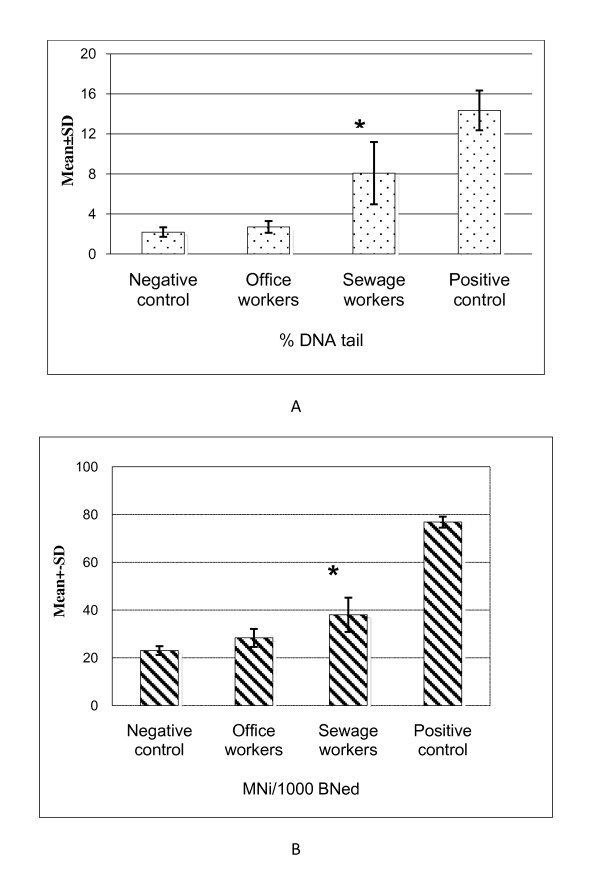
Effects of 24 h exposure to urine organic extract evaluated by comet and micronucleus assay performed on HepG2 cells. A) The bars are related to the means ± SD values of percent DNA tail obtained by comet assay. B) The bars are related to means ± SD values of MNi/1000 BNed obtained by Micronucleus assay. For comet assay, nine experiments were performed. For micronucleus assay, five experiments were performed. For both assays and in each experiment, B(a)P 40 μM and DMSO 1% final concentrations were the positive and negative controls; respectively. *Statistically significant (P < 0.001) compared to office workers. BNed, Binucleated cells MNi, micronuclei.